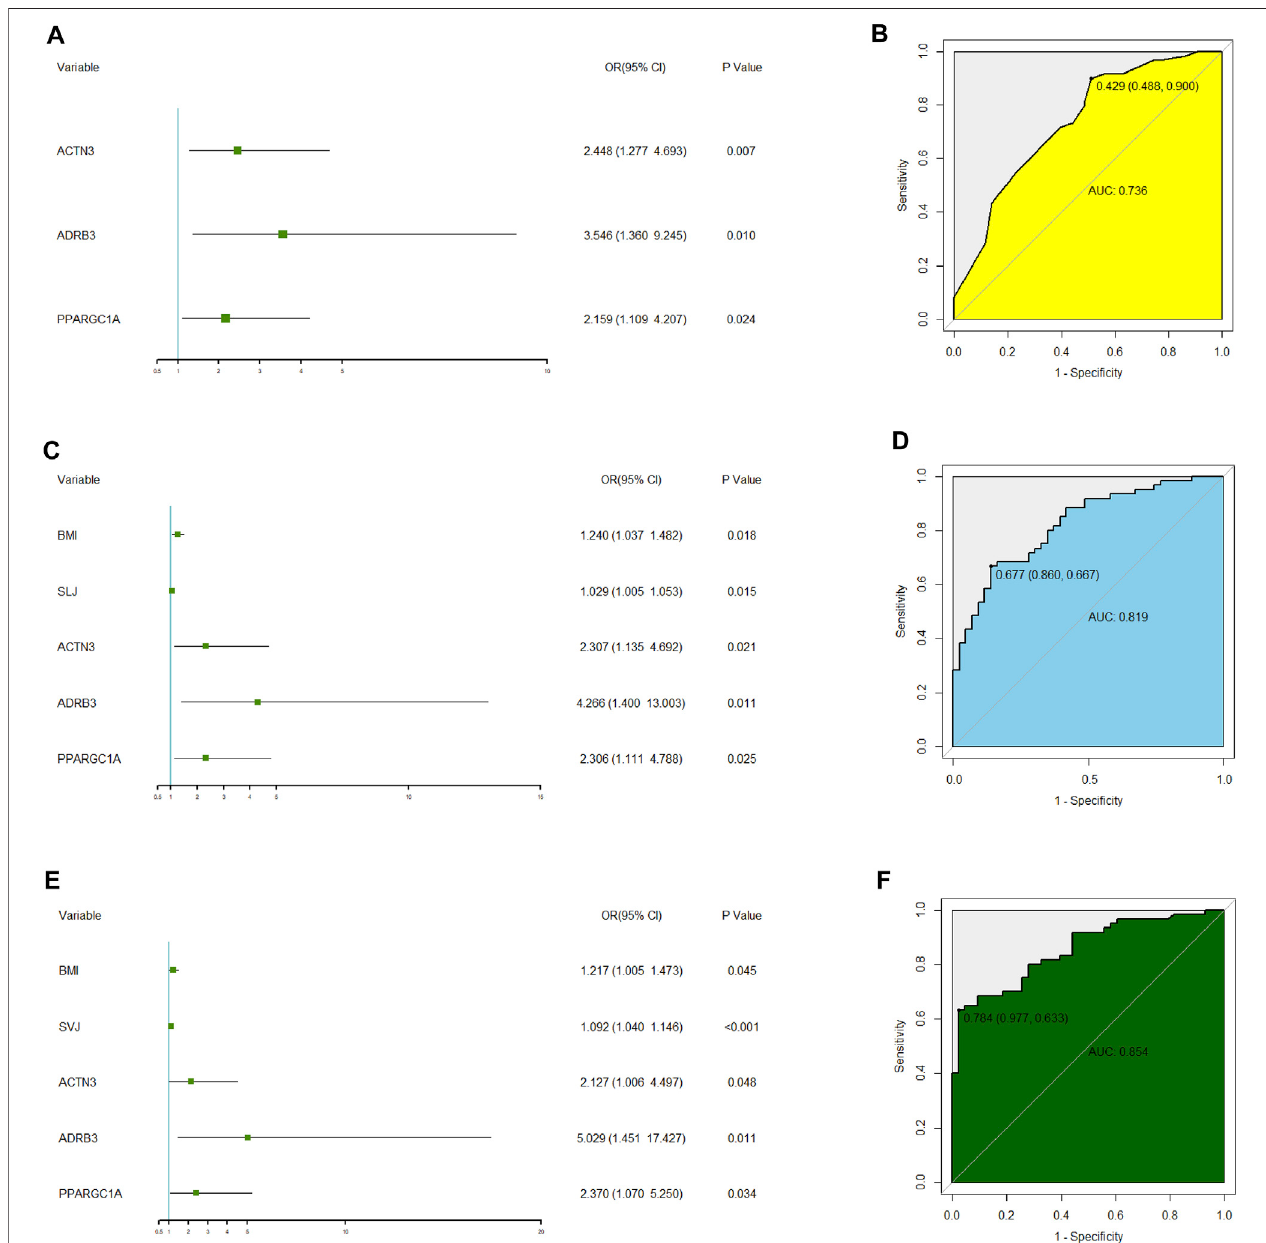
FIGURE 2 | Multivariate logistic regression analysis of three polygenic models related to elite power performance and their ROC analysis. (A) Forest plot of multivariate logistic regression analysis for the model1 only including three SNPs. (B) Receiver operating characteristic (ROC) curve analysis to summarize the ability of the model1 to predict potential elite power performance from elite endurance performance. AUC: area under the curve. (C) Forest plot of multivariate logistic regression analysis for the model 4 including three SNPs, BMI and SLJ. (D) Receiver operating characteristic (ROC) curve analysis to summarize the ability of the model4 to identify elite power performance from elite endurance performance. AUC: area under the curve. (E) Forest plot of multivariate logistic regression analysis for the model 5 includingthreeSNPs,BMIandSVJ. (F) Receiver operatingcharacteristic(ROC)curveanalysistosummarizetheabilityofthemodel5toidentifyelitepowerperformance from elite endurance performance. AUC: area under the